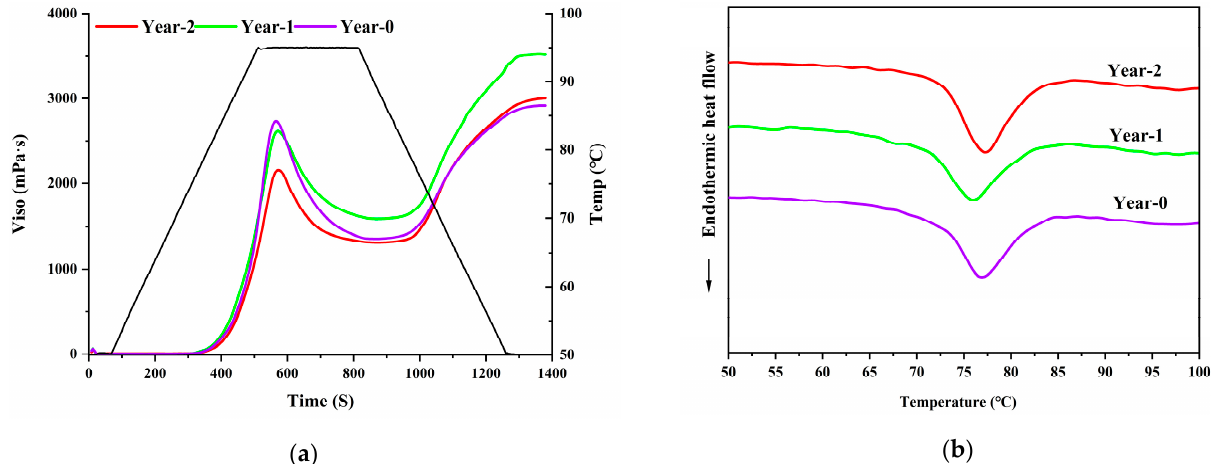
Figure 4. Rice pasting and thermal property variation during storage. ( a ) Rice starch RVA diagram; ( b ) Rice DSC diagram. Table 4. Rice pasting properties variation in storage.